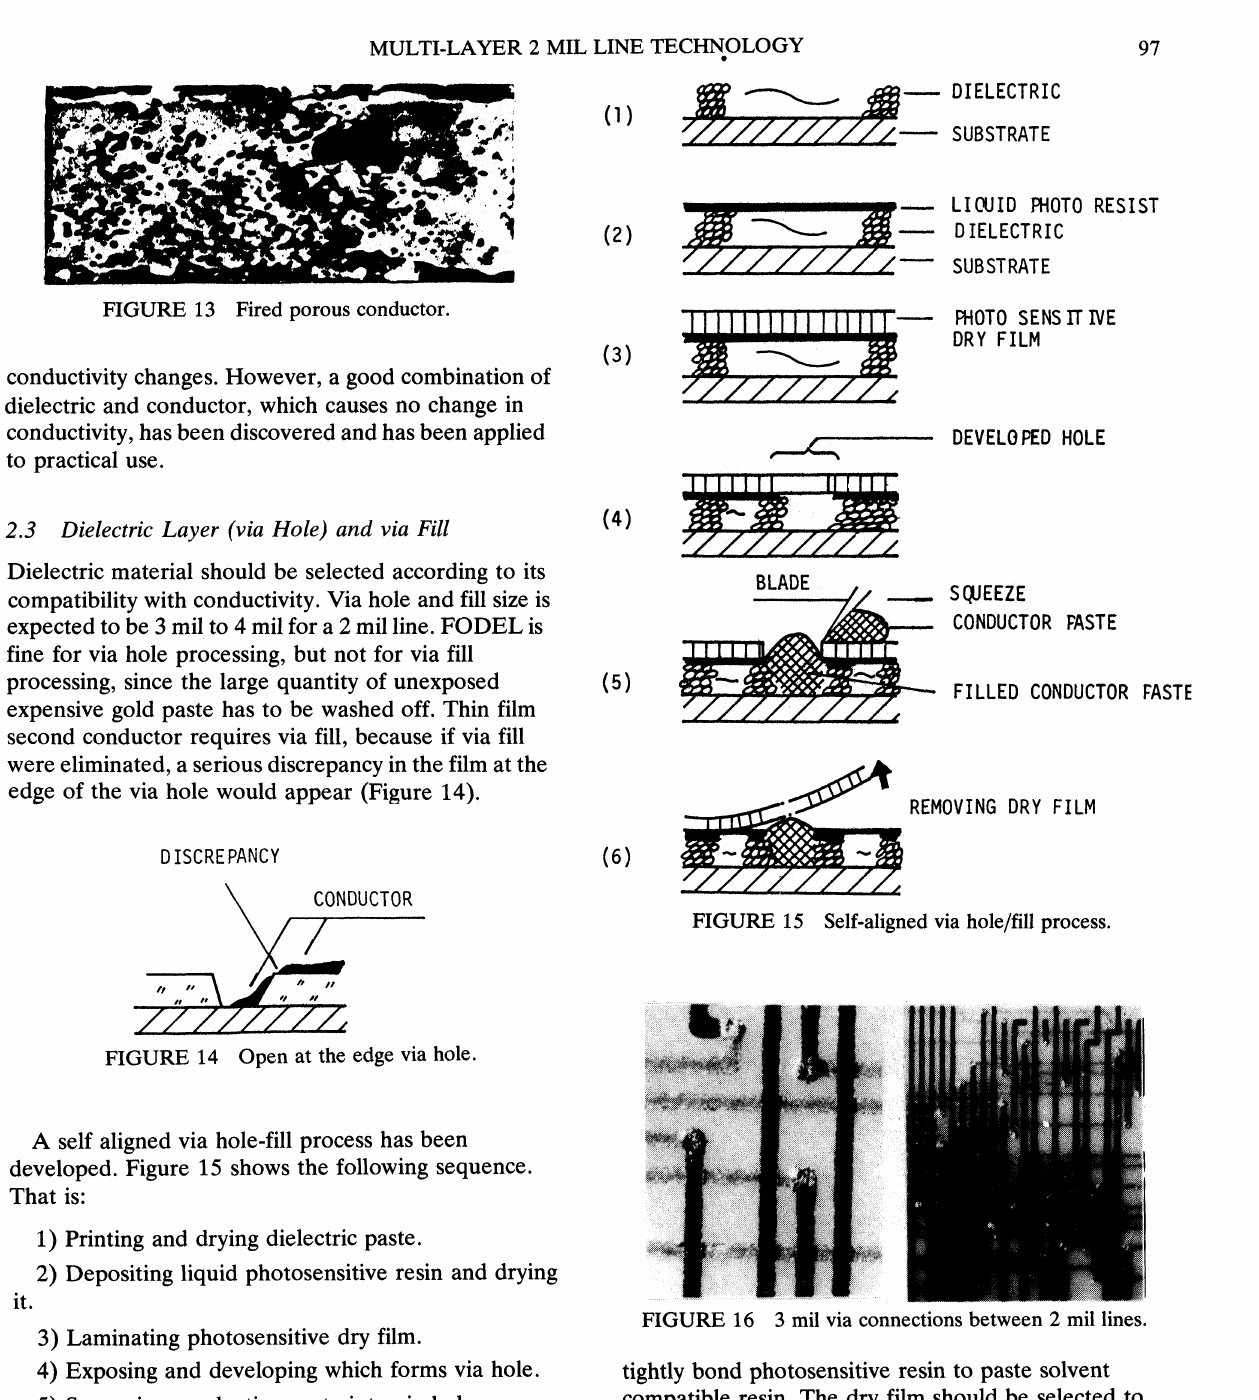
FIGURE 16 3 mil via connections between 2 mil